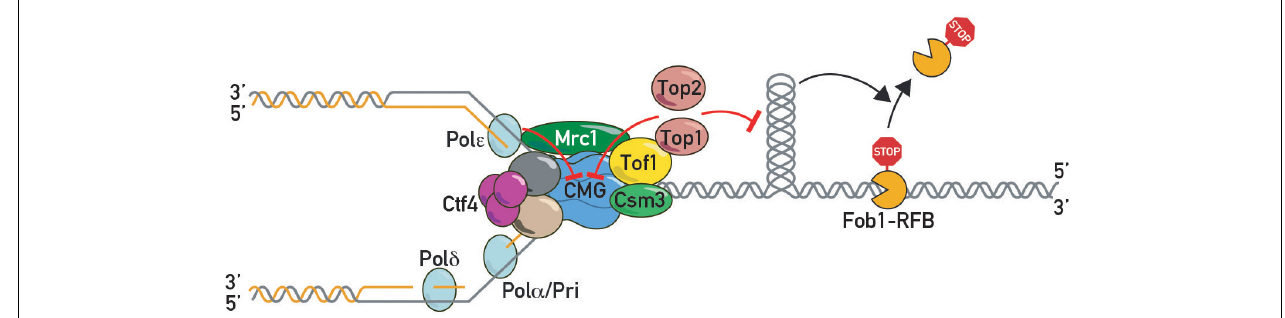
FIGURE 4 | DNA topoisomerases in pausing. Topoisomerase I and II slow down replication forks at protein barriers either by direct inhibition of CMG helicase or indirectly by preventing build-up of barrier-disrupting DNA topology.